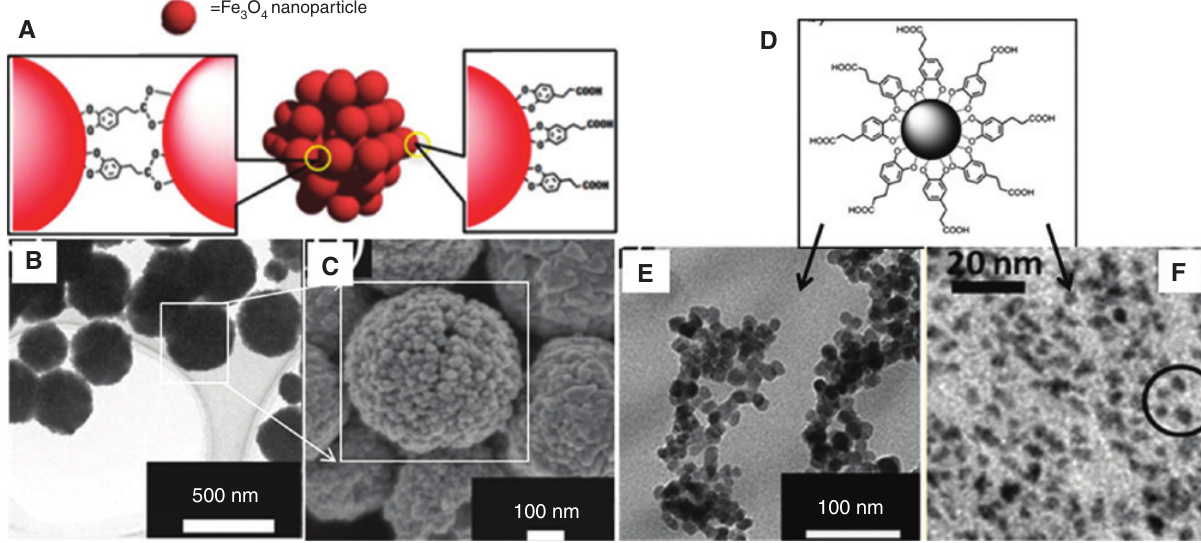
O (reprinted with permission from Togashi T, Naka T, Asahina S, Sato K, Takami S, Adschiri T, 3 4